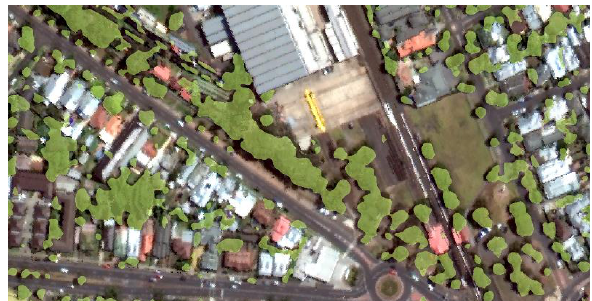
Figure 9. Tree canopy cover